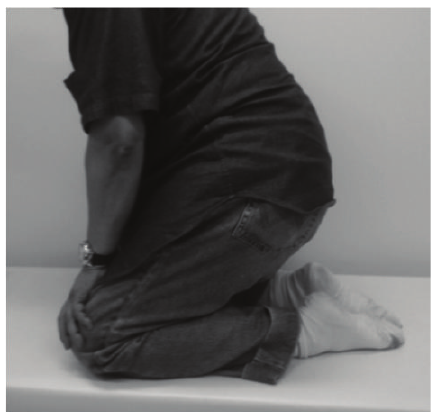
Figure 13: Flexion was still insufficient and rehabilitation is ongoing one year after the surgery.